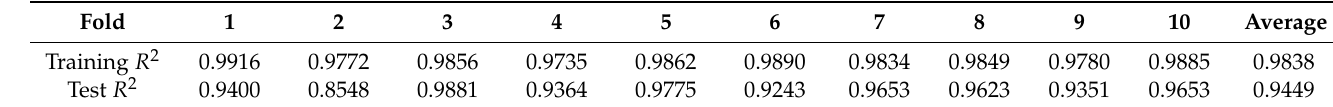
Table 2. The training and test R 2 scores of 10-fold cross validation for evaluating thermal conductivity for WC-Co system. The average R 2 is shown in the last column.